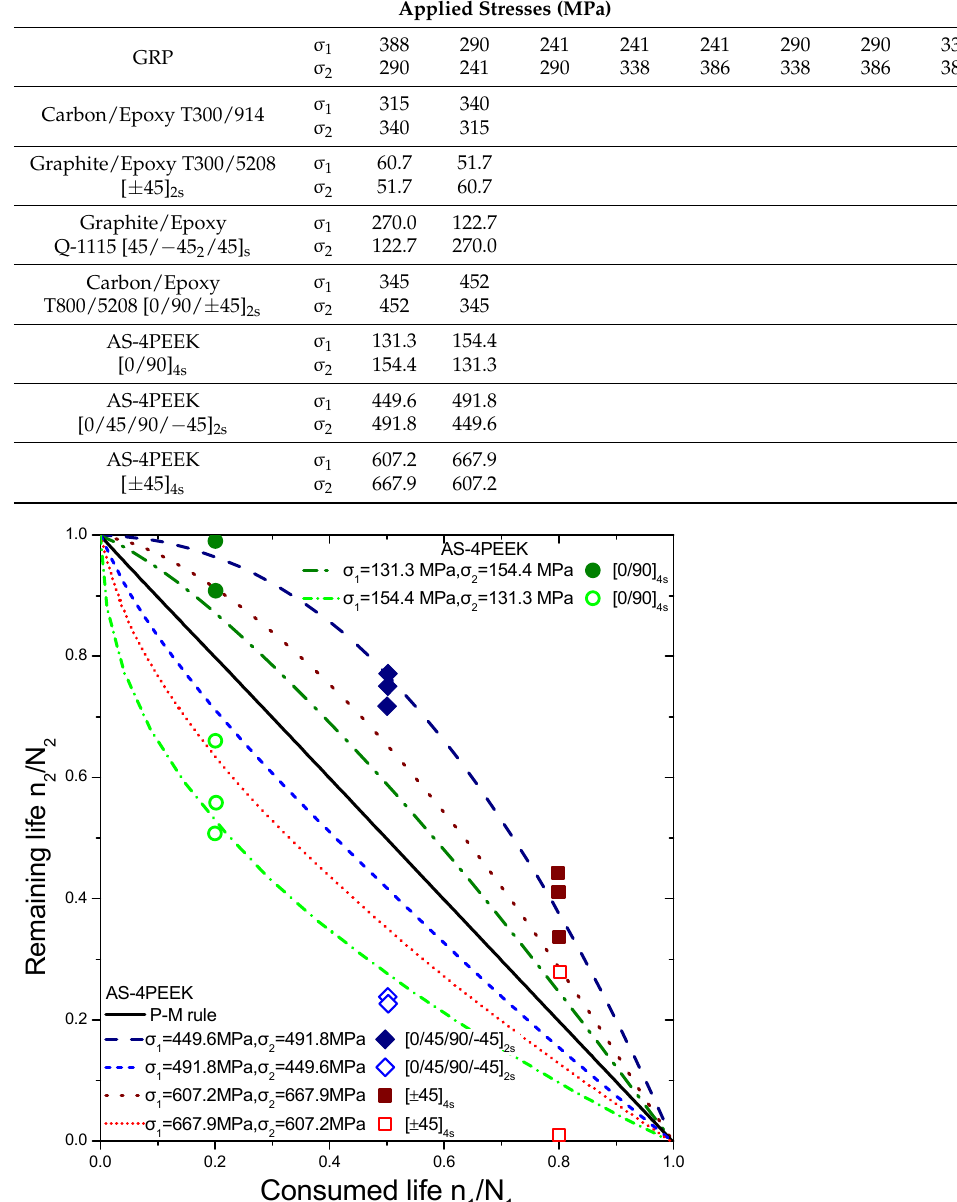
Table 2. Loading conditions for the composite materials under investigation.